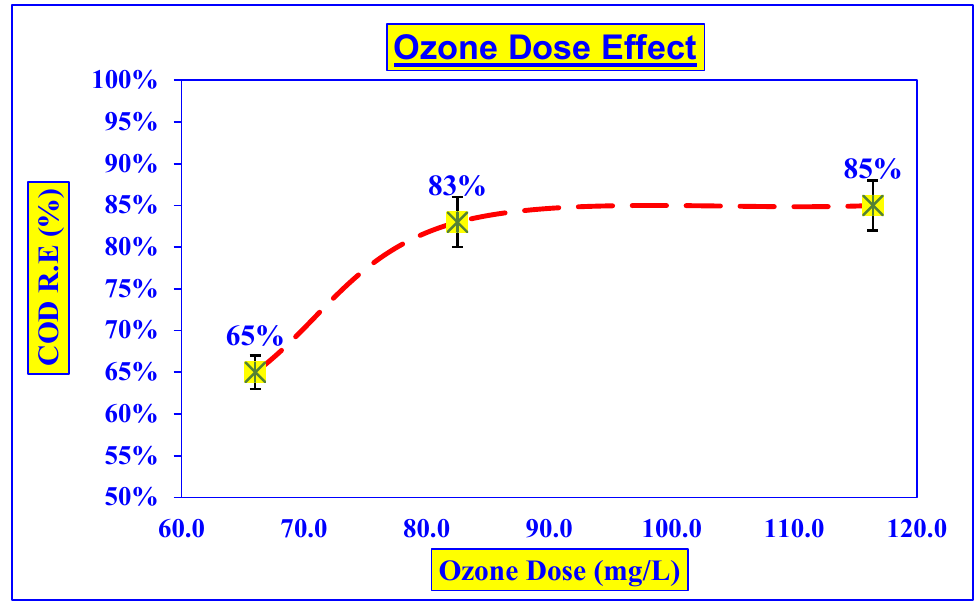
Figure 2. Ozone dose optimization in ozonation process (O 3 = 66.0 ± 1.5 mg/L, 82.5 ± 2.2 mg/L, 116.40 ± 3.6 mg/L; pH = 6.9 ± 0.2; C.T = 15 min; volume = 4 L; T = 25 ± 2 ◦ C).